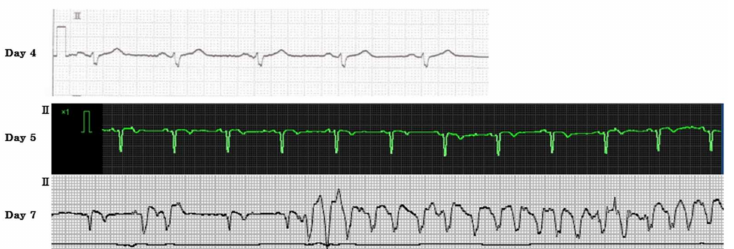
Figure 2. Electrocardiogram: II lead showed the right bundle branch block on day 4; monitor showed a negative T wave on day 5; sporadic ventricular tachycardia appeared on day 7.